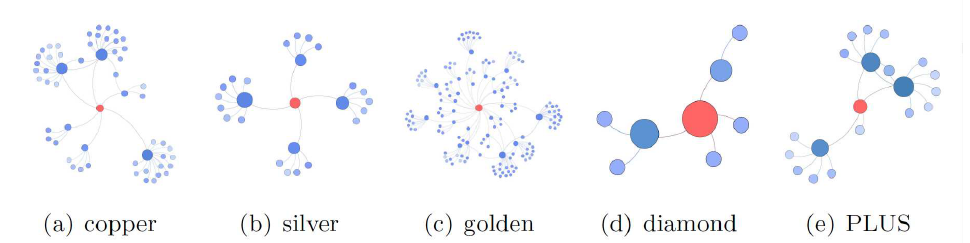
Figure 8. Semantic network of ‘match’ for five user levels ( N = 4 ). The red node in each network refers to the word ‘match’, and the blue nodes are the words that are the top-four similar synonyms in each level. The sizes of the nodes refer to their